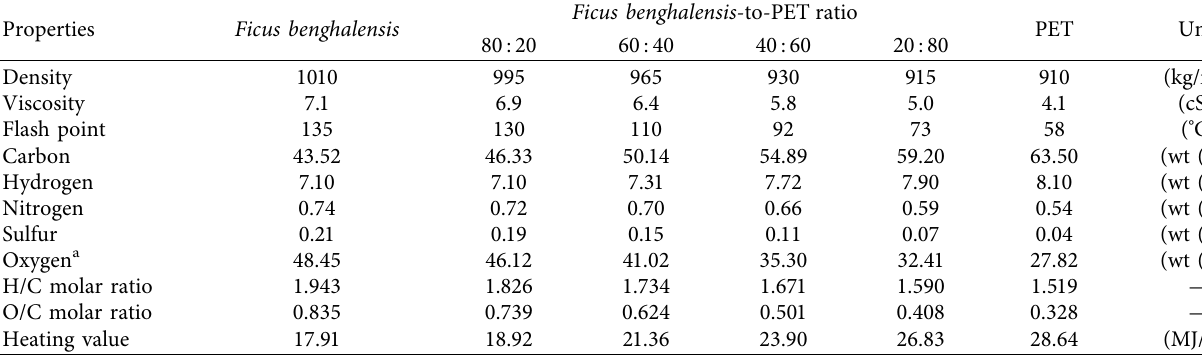
Table 2: Physical properties of the oils.